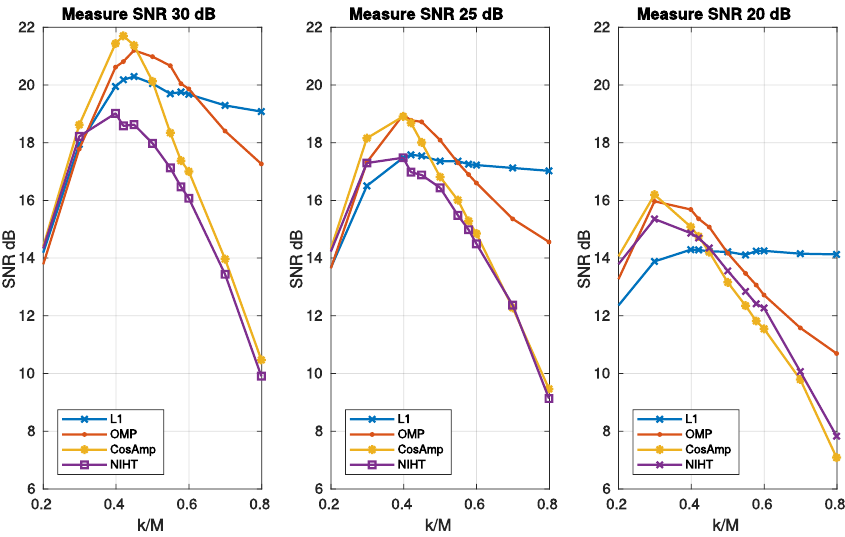
Figure 7. Case Study A—SNR as a function of sparsity S M = k / M for the four algorithms and three values of noise superimposed to the signal.